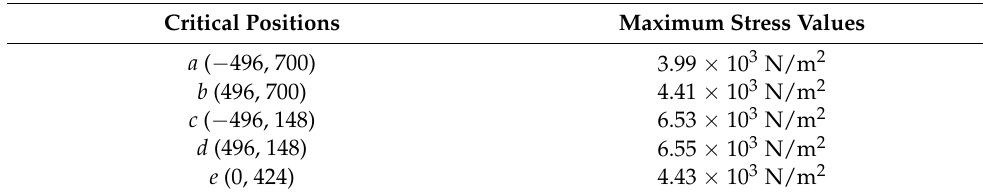
Figure 13. Stress results when Nurse reaches critical positions: ( a ) critical position d (496, 148); ( b ) critical position e (0, 424). Table 6. Maximum stress values on the human arm when Nurse reaches five critical positions.